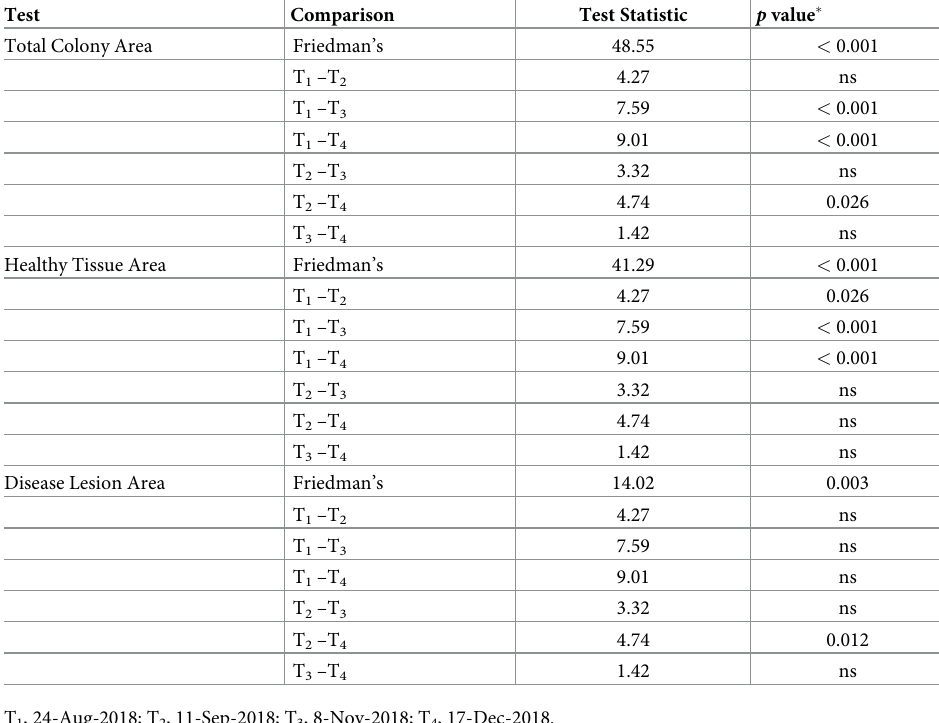
Table 2. Results of Friedman’s rank sum tests comparing total colony area, disease tissue area and healthy tissue area across time, with pairwise comparisons made using Nemenyi